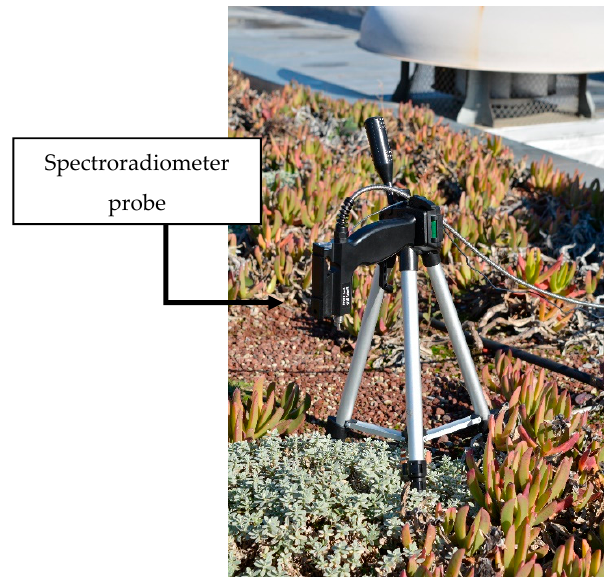
Figure 3. Spectroradiometer measuring spectral signatures of vegetation on a green roof (Piro et al. 2017).